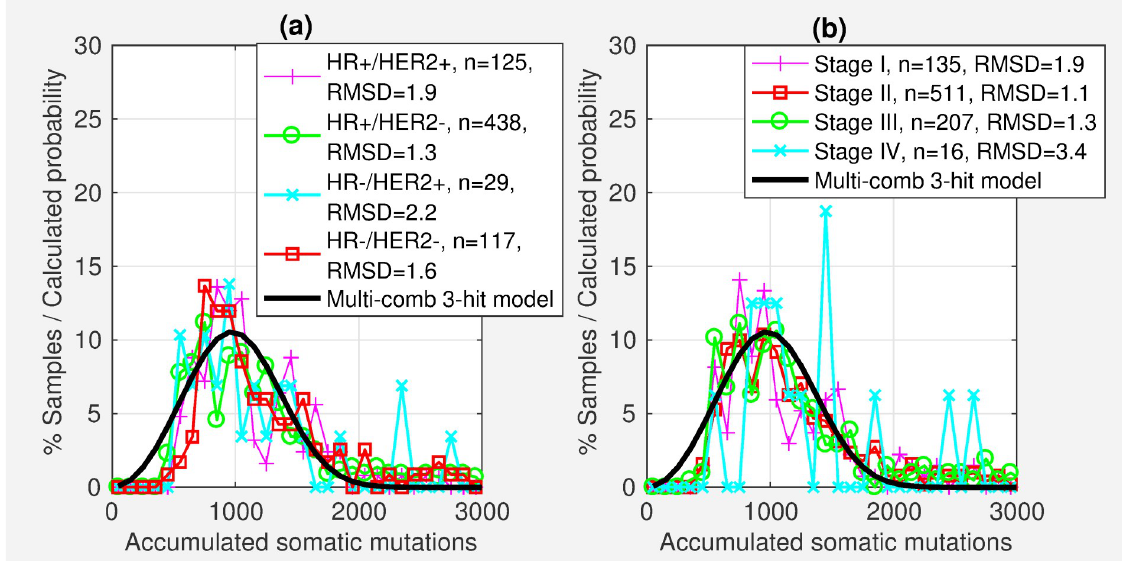
Fig 6. Distribution of somatic mutations for breast invasive carcinoma (BRCA) is similar by subtype and stage. The estimated number of hits is identical for subsets of BRCA samples by (a) subtype and (b) stage.